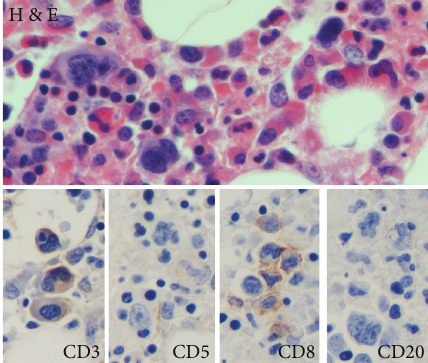
Figure 1: Light micrograph of hematoxylin and eosin stained colon biopsies showing high grade T-cell lymphoma cells deep within the glands. Figure 2: Light micrograph of hematoxylin and eosin stained bone marrow section showing lymphoma cells with atypical nuclei. Immunohistochemistry (CD3, CD5, and CD8) illustrates the T-cell origin of the lymphoma. CD20 was also noted to be weakly